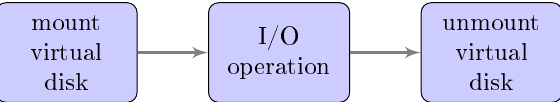
Figure 2. Access Sequence when the host performs an I/O operation on the virtual disk which may be mounted on a VM down. This means that archive uploads are unavailable while the guest system is